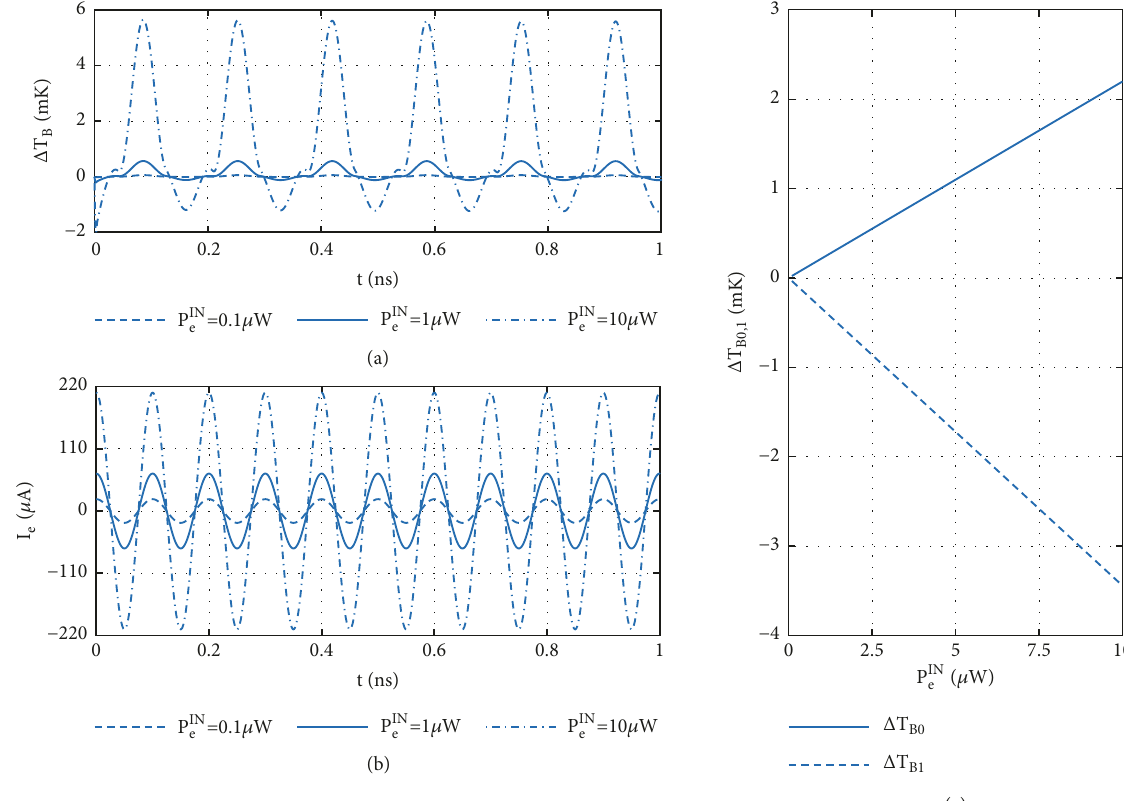
Figure 2: (a) Timeevolution of (a) the temperaturedrop Δ𝑇 𝐵 = Δ𝑇 𝐵0 +Δ𝑇 𝐵 (𝜔) across the tunnelbarrier of MTJand (b)an alternatingcurrent with a frequency of 6 GHz at a variable power. (c) Dependence of the magnitude of the constant and variable first-harmonic temperature drops Δ𝑇 𝐵0 and Δ𝑇 𝐵1 on the heating